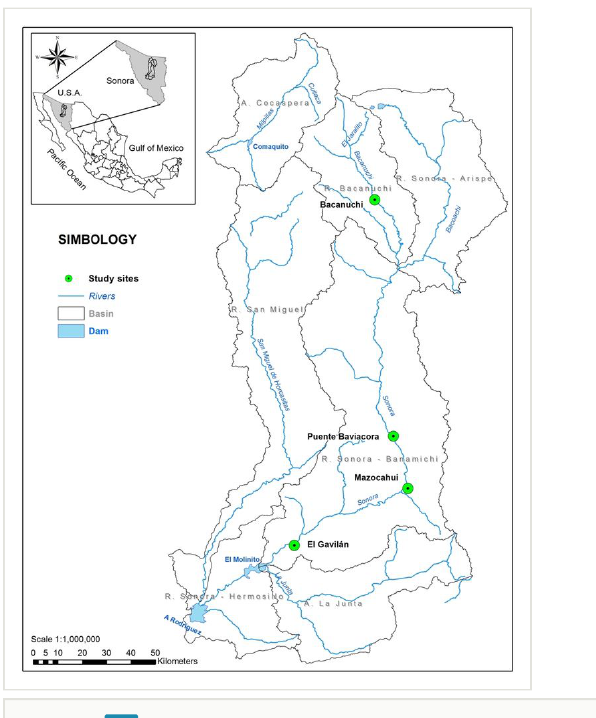
Figure 1. Localities where Xestochironomus larvae were captured in the Sonora River, north-western